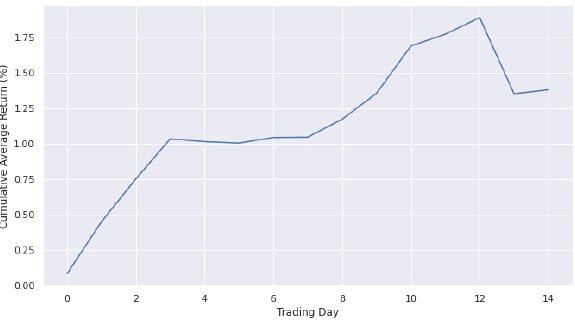
Figure 9. Cumulative average return performance from BO approach in testing period.